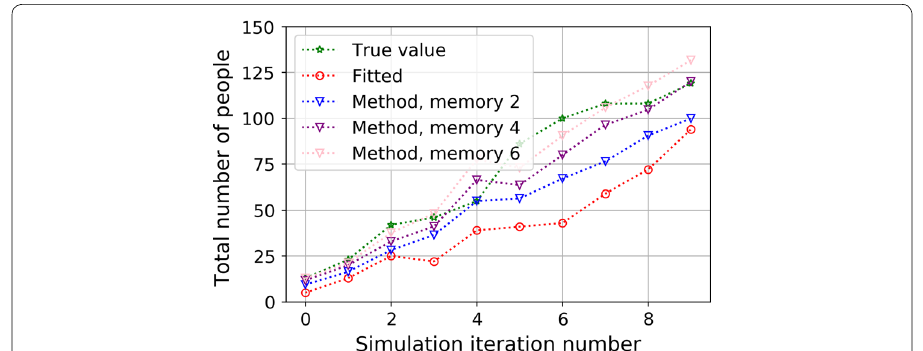
Fig. 6 Performances for full simulation, varying the ‘memory’ parameter